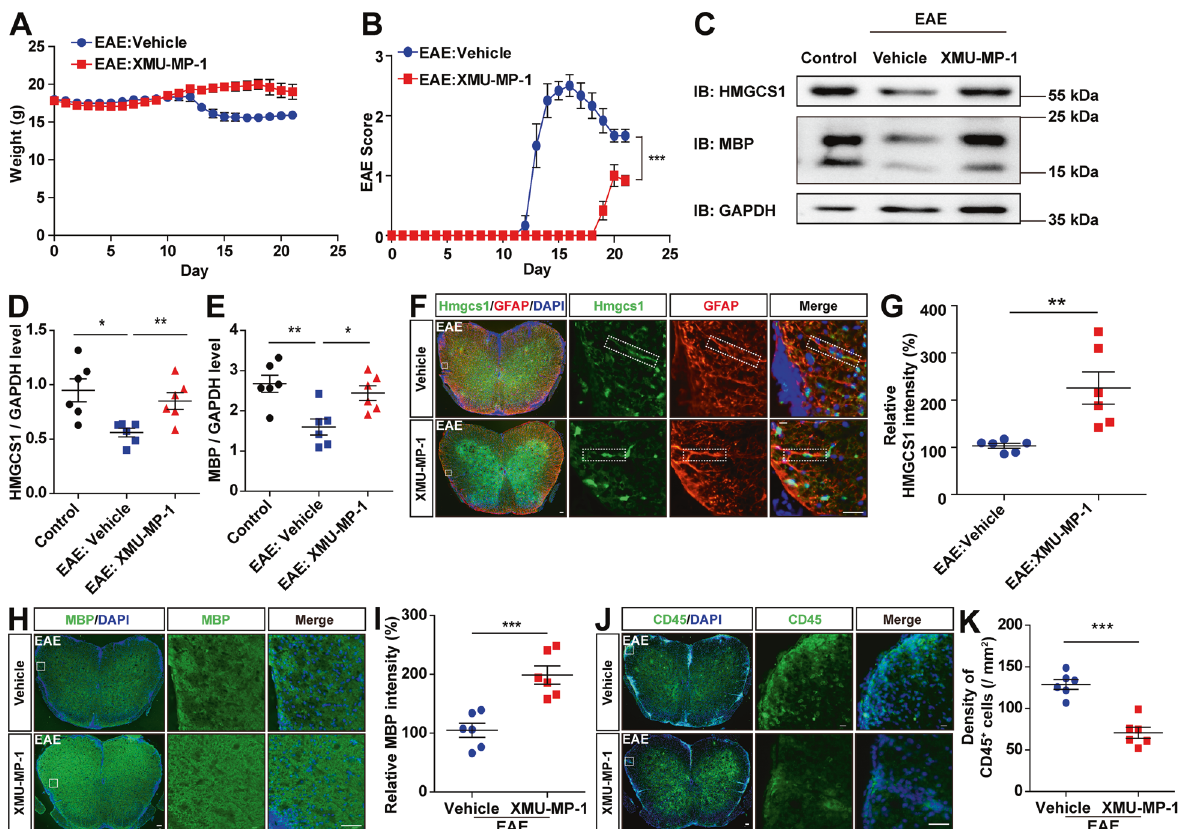
Fig. 7 The activation of YAP signaling prevented the demyelination and neuroin fl ammation, and improved the functional recovery of EAE mice. A The body weight of vehicle-treated mice and XMU-MP-1-treated mice from 0 to 21 dpi during the EAE modeling process ( n = 6, two-way ANOVA with Bonferroni ’ s post-tests). B The EAE score of vehicle-treated mice and XMU-MP-1-treated mice 0 – 21 dpi during the EAE modeling process ( n = 6, two-way ANOVA with Bonferroni ’ s post-tests). C Western blot showed the HMGCS1 and MBP expression in the lumbar spinal cords of vehicle-treated EAE mice and XMU-MP-1-treated EAE mice. D , E Quanti fi cation of HMGCS1 ( D ) and MBP ( E ) protein level as shown in C ( n = 6, normalized to GAPDH, one-way ANOVA with Bonferroni ’ s post-tests). F Immunostaining of HMGCS1 (green) and GFAP (red) in the lumbar spinal cords of vehicle-treated EAE mice and XMU-MP-1-treated EAE mice. G Quanti fi cation of the relative intensity level of HMGCS1 as shown in F (normalized to vehicle EAE group, n = 6). H Immunostaining of MBP (green) in the lumbar spinal cords of vehicle- treated EAE mice and XMU-MP-1-treated EAE mice. I Quanti fi cation of the relative intensity of MBP as shown in H (normalized to vehicle EAE group, n = 6). J Immunostaining of CD45 (green) in the lumbar spinal cords of vehicle-treated EAE mice and XMU-MP-1-treated EAE mice. K Quanti fi cation of the density of CD45 + cells as shown in J ( n = 6). Scale bars, 50 μ m. Data were mean ± SEM. Student ’ s t -test unless otherwise indicated, * p < 0.05, ** p < 0.01, *** p < 0.001.